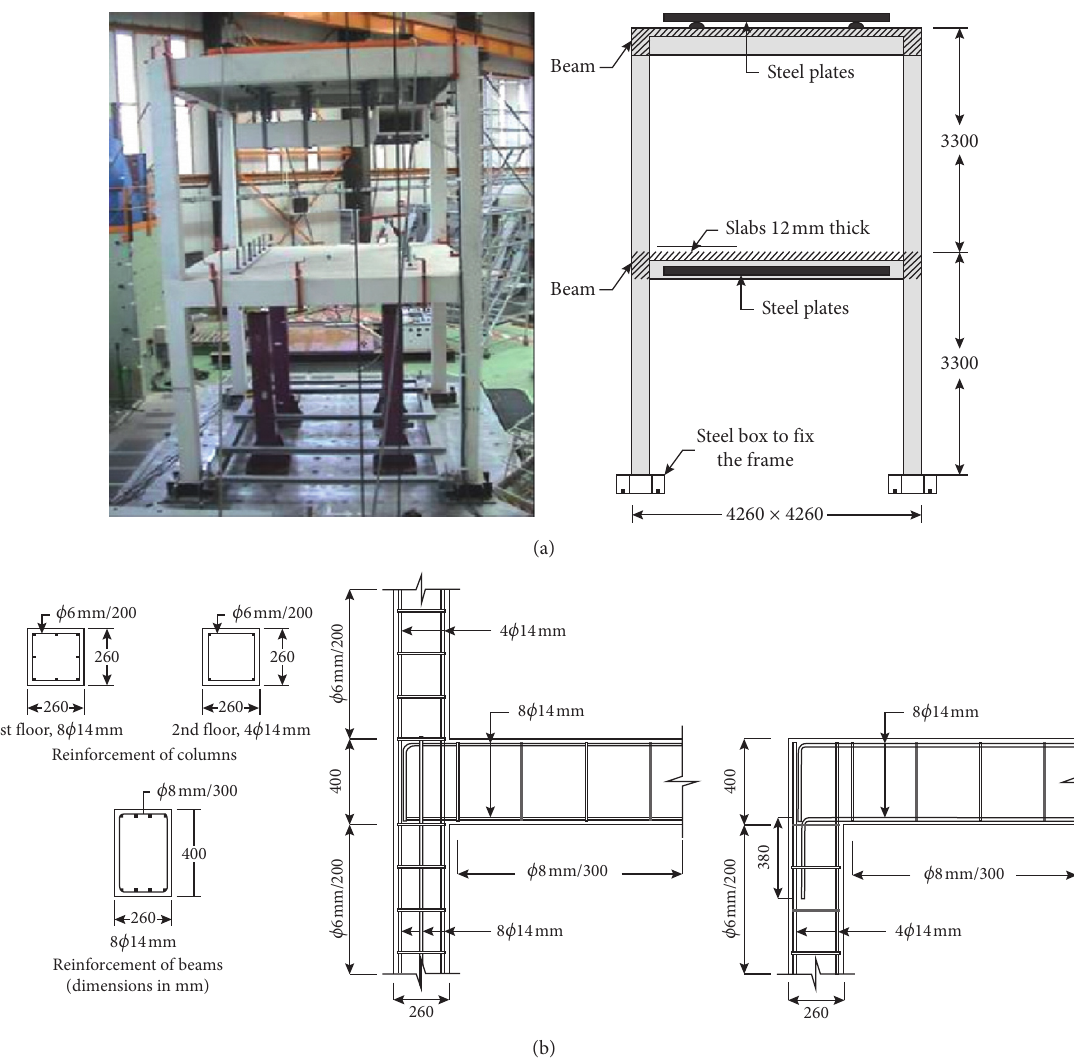
Figure 6: Full-scale 2-storey frame [34, 71]. (a) General view. (b) Cross sections and reinforcement arrangement.